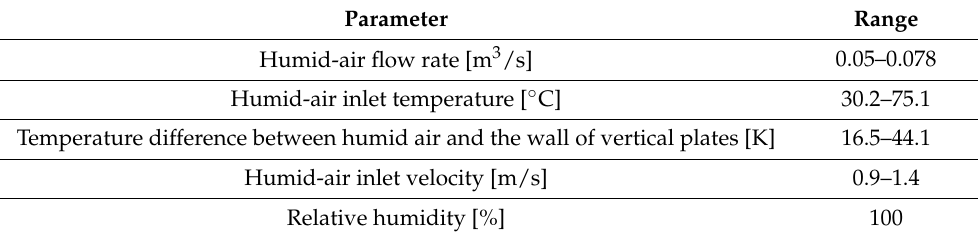
Table 3. Range of process parameters valid for Equation (4).